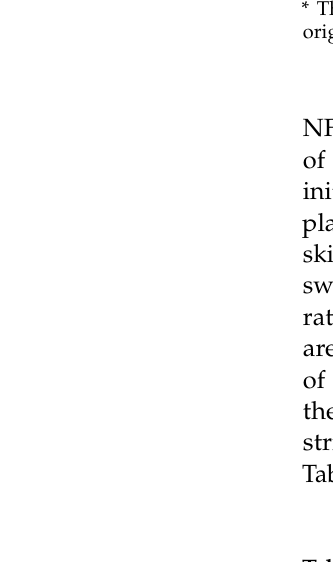
Table 3. Diagnostic criteria for Legius